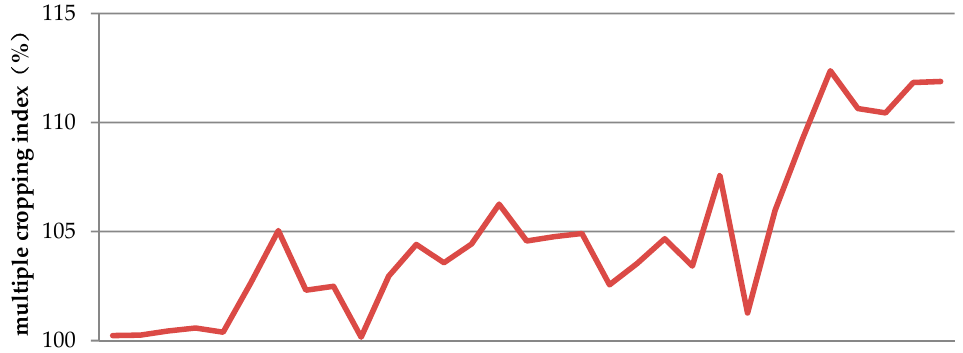
Figure 6. Change of the multiple cropping index of Sujiatun District from 1980 to 2010.